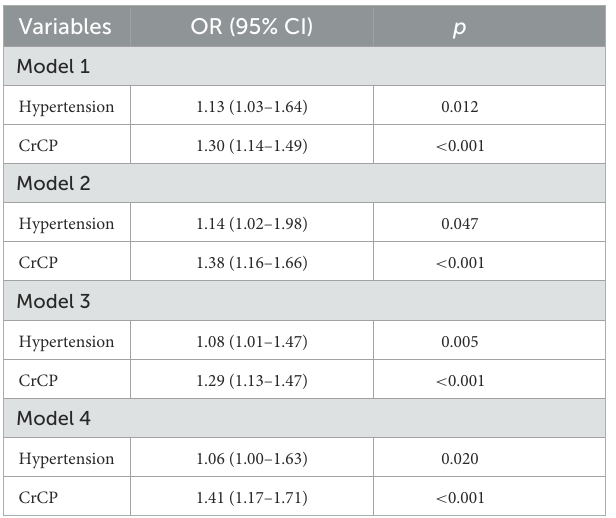
TABLE 2 Determinants of CSVD burden in multivariate models a